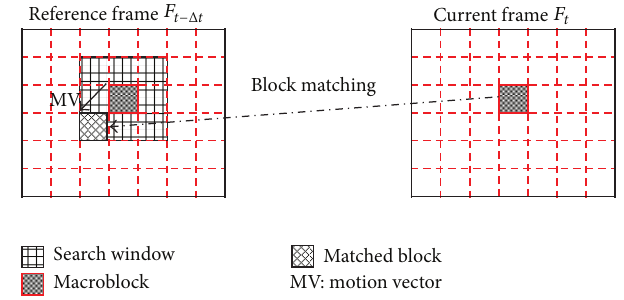
Figure 1: Block-matching process.